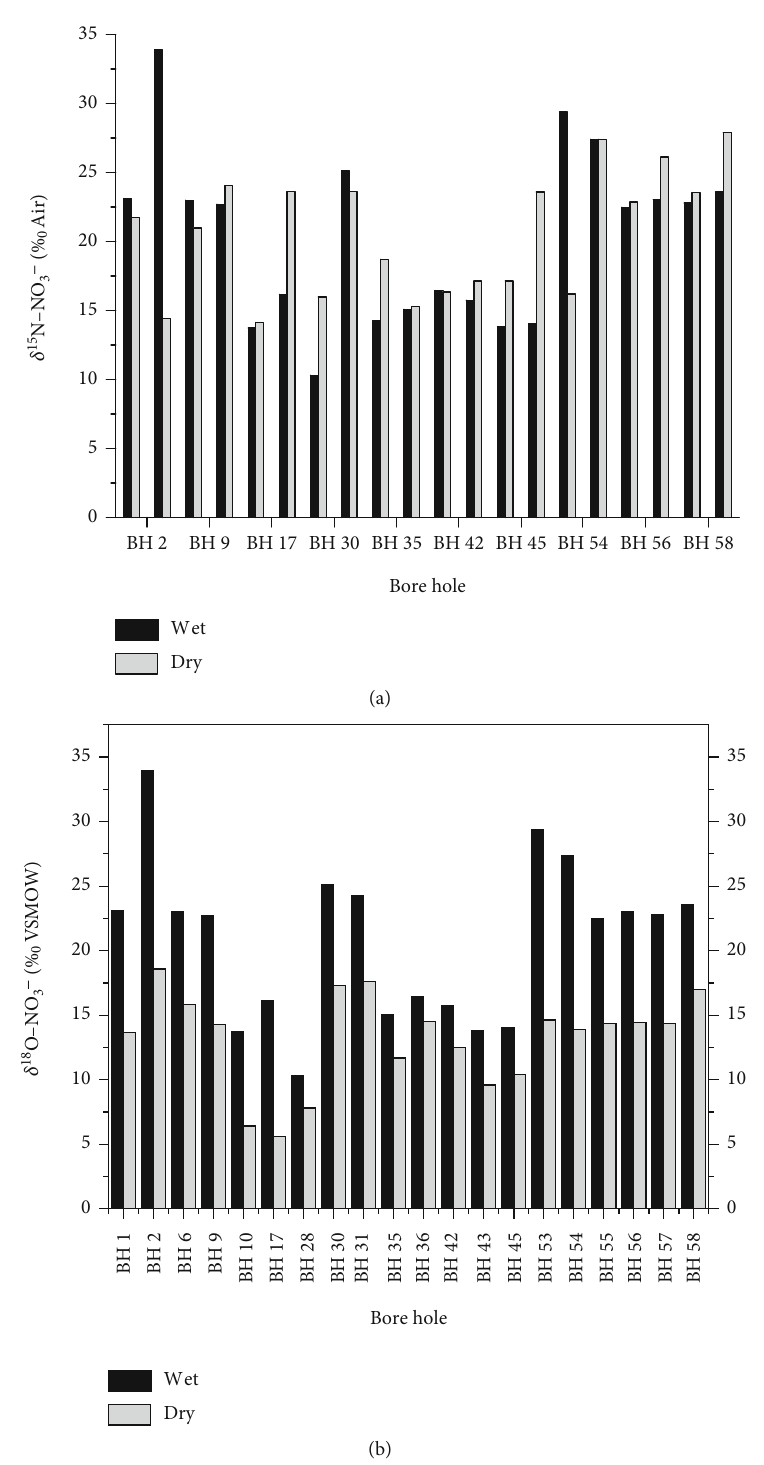
− and (b) δ 18 O-NO − in Figure 9: The isotopic signatures for (a) δ 15 N-NO 3 3 during the wet season (Table 3) while during the dry season, chloride and nitrate ( n = 23 , r = 0 : 70 ) (SI Table 2a), an early a strong positive correlation ( n = 23 , r = 0 : 50 ) was observed indication of wastewater pollution [18]. Chloride between chloride and nitrate in shallow wells. A very strong concentrations ranged from 9.9 ppm to 675.7 ppm in the positive correlation in shallow wells was observed between dry season and from 3.9 ppm to 893.7 ppm in the wet nitrate and chloride concentrations ( n = 23, r = 0 : 70 , 0.58) (SI season (Table 1). Also, there was a moderate positive Table 2b), during the wet and the dry season, respectively. correlation between nitrite and ammonium ( n = 23 , r = 0 : 47 )